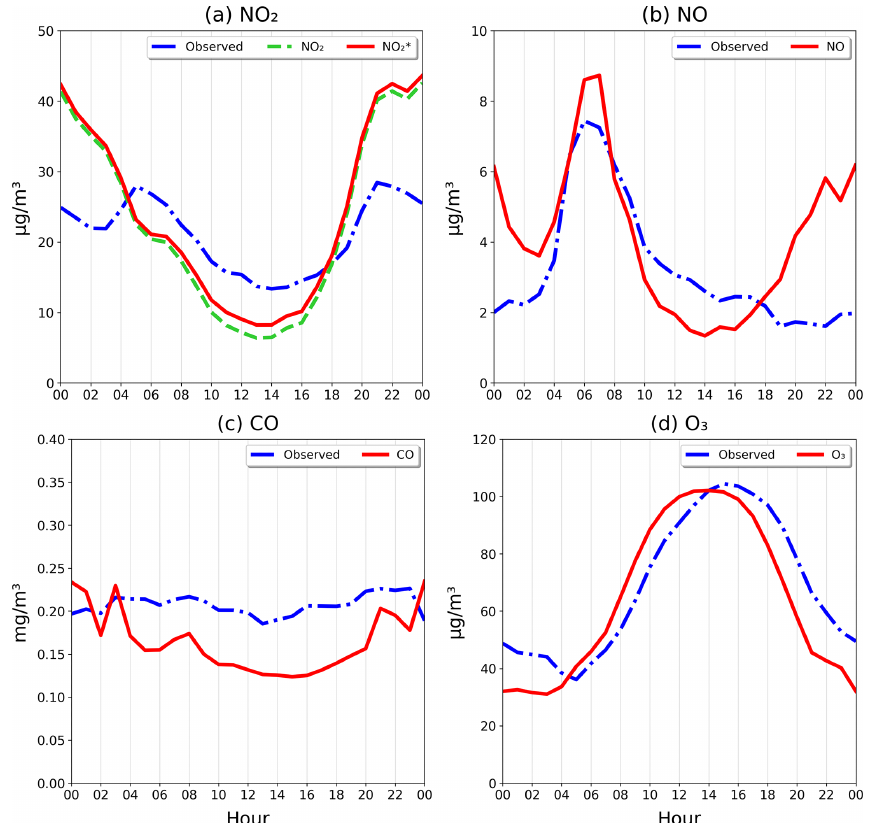
, (b) NO, (c) CO, and (d) O 3 . Model results from the 2